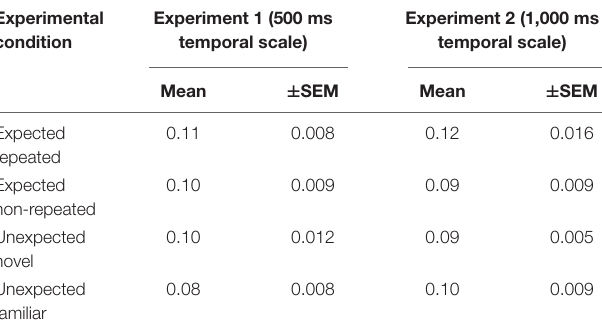
TABLE 3 | Weber fractions (mean and the standard error of the mean, SEM) for each experimental condition in Experiment 1 and Experiment